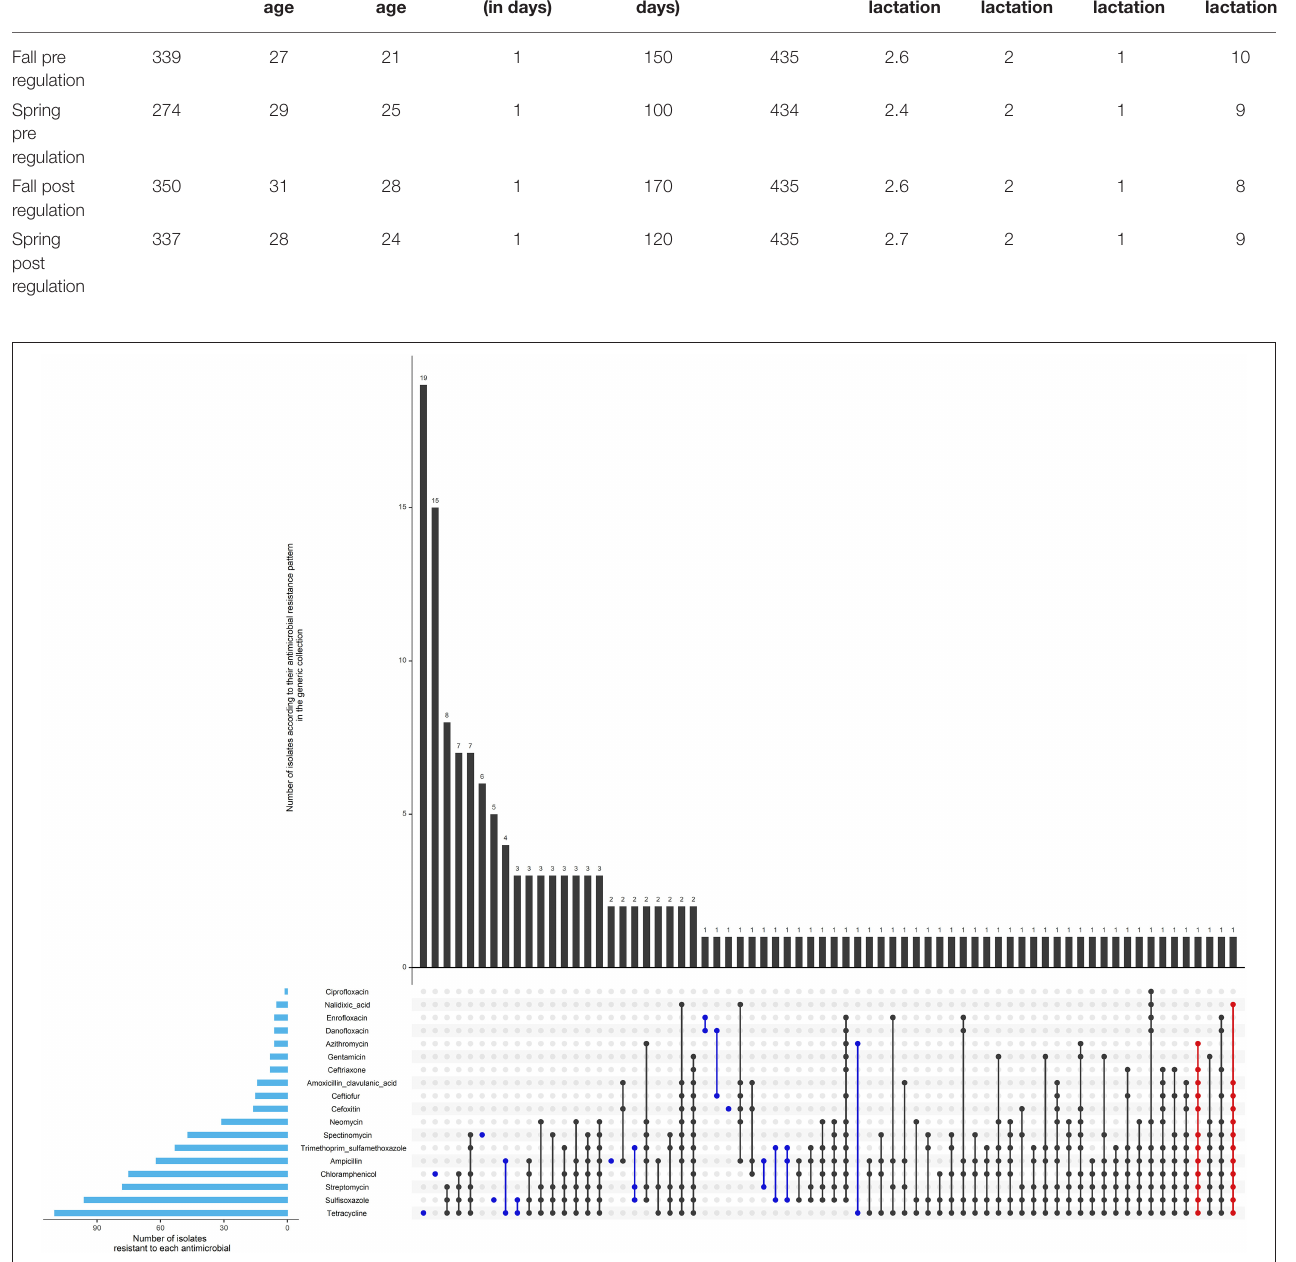
azithromycin and danofloxacin with correlation of 80 and 93%, respectively. We also identified genes responsible for resistance